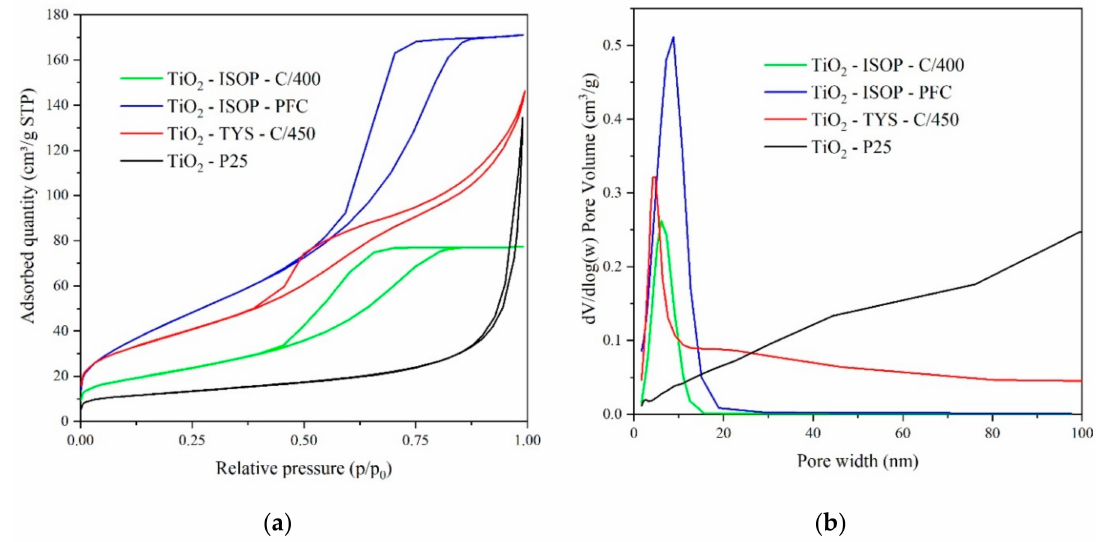
Figure 1. Adsorption / desorption isotherms ( a ) and evaluated pore-size distributions ( b ) of investigated TiO 2 photocatalysts.